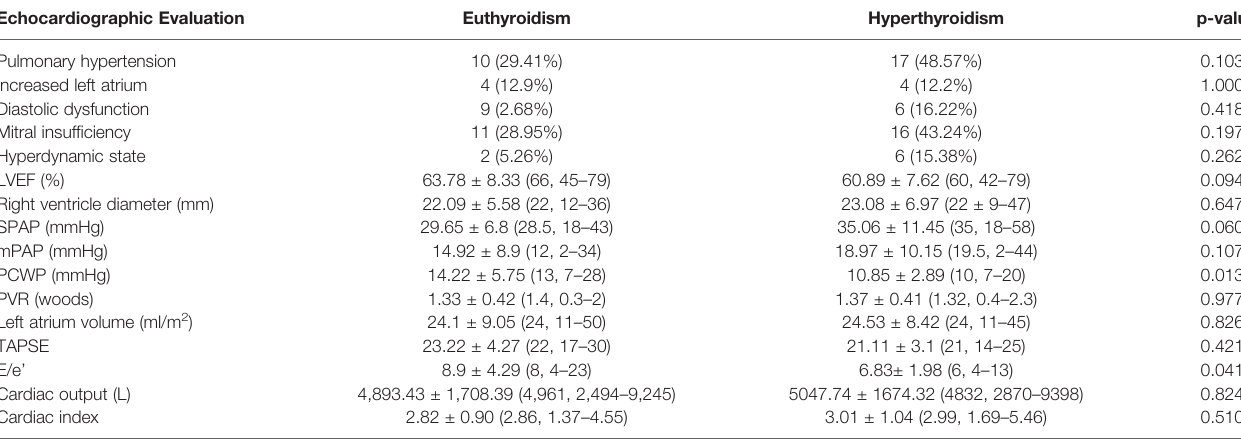
LVEF, left ventricular ejection fraction by the Simpson method; SPAP, systolic pulmonary artery pressure; mPAP, mean pulmonary artery pressure; PCWP, pulmonary capillary Wedge pressure;PVR,pulmonaryvascularresistance;TAPSE,tricuspidannularplanesystolicexcursion;E/e ’ ,ratiobetweenthediastolicvelocityEofthemitral fl owandthediastolicvelocityofthe mitral ring. Categoricalvariablesarerepresentedbytheabsolutevalueandfrequencyinpercentage.Continuousvariablesarerepresentedbyvaluesofmean±standarddeviation(median,minimum, and